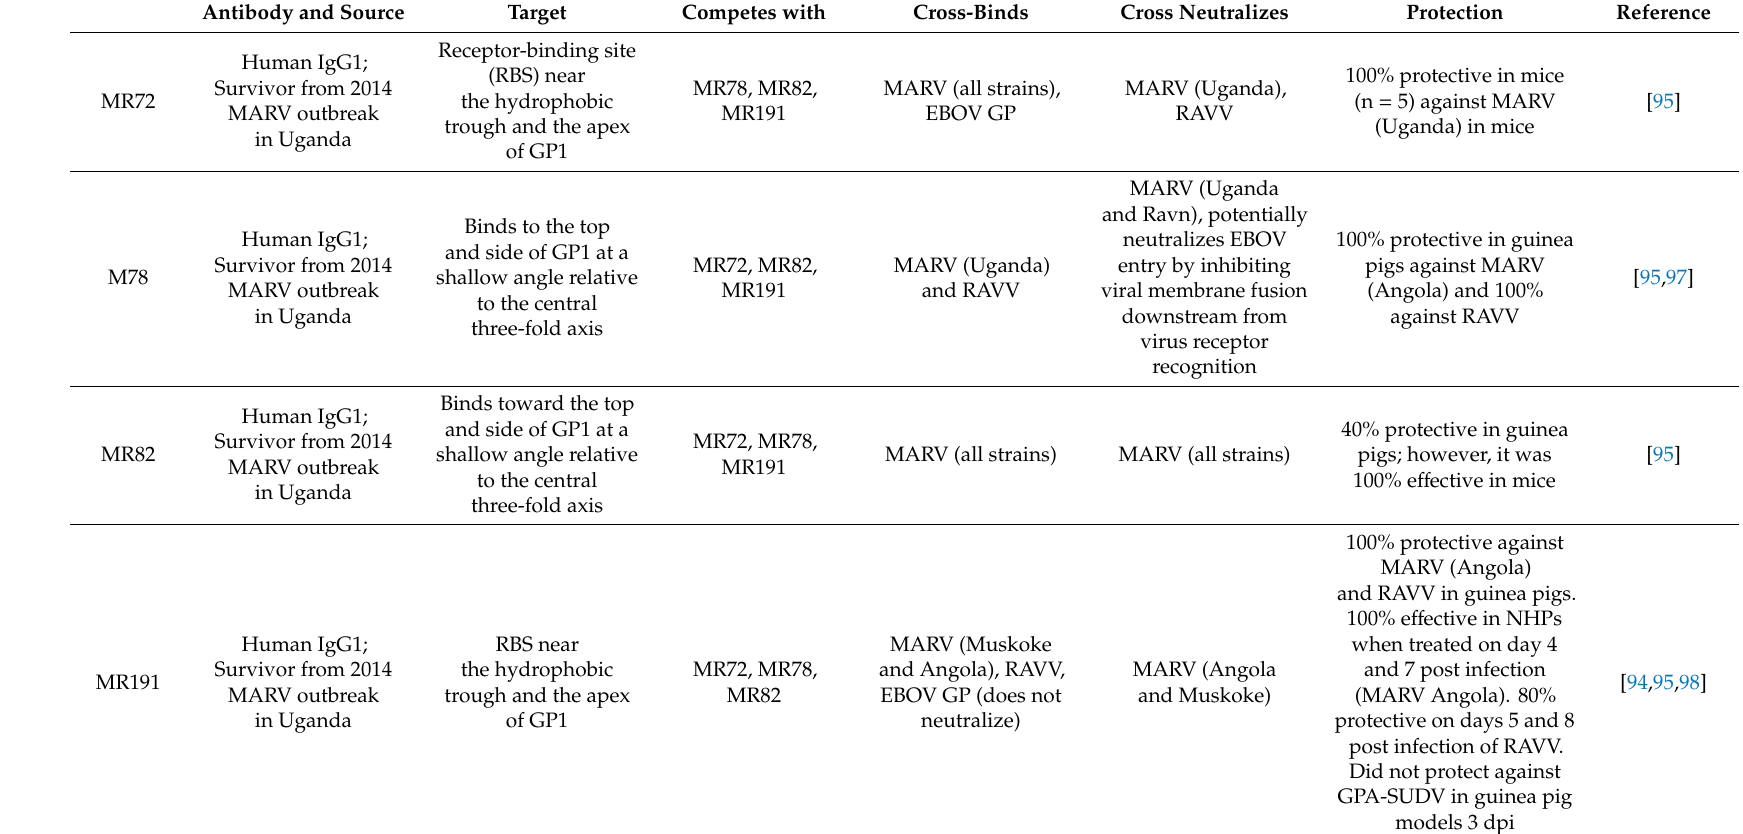
Table 1. Top performing mAbs for MARV from human